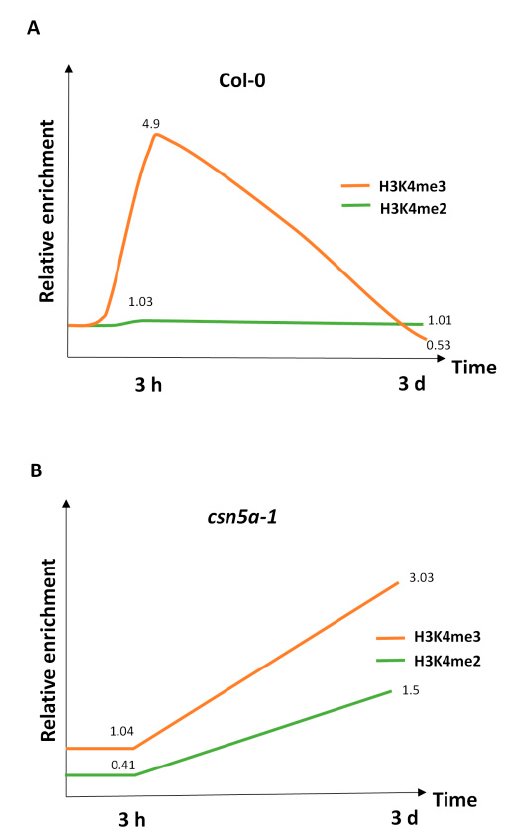
Figure 5. Restoration of H3K4me3 to the baseline 3 d after recurrent heat stress depends on CSN5A. ( A ) Presence of CSN5A induces the levels of H3K4me3 3 h after recurrent heat stress (2 h, 44 ◦ C, 7 d); furthermore, CSN5A is also required to decrease the levels of H3K4me3 to the baseline after 3 d of recurrent heat stress. The H3K4me2 level is not affected by recurrent heat stress in Col-0. ( B ) In the absence of CSN5A ( csn5a-1 ), the H3K4me3 level does not elevate 3 h of recurrent heat stress while levels of H3K4me3 as well as H3K4me2 elevate 3 d after recurrent heat stress. These figures were drawn based on APX2 region 2 data.